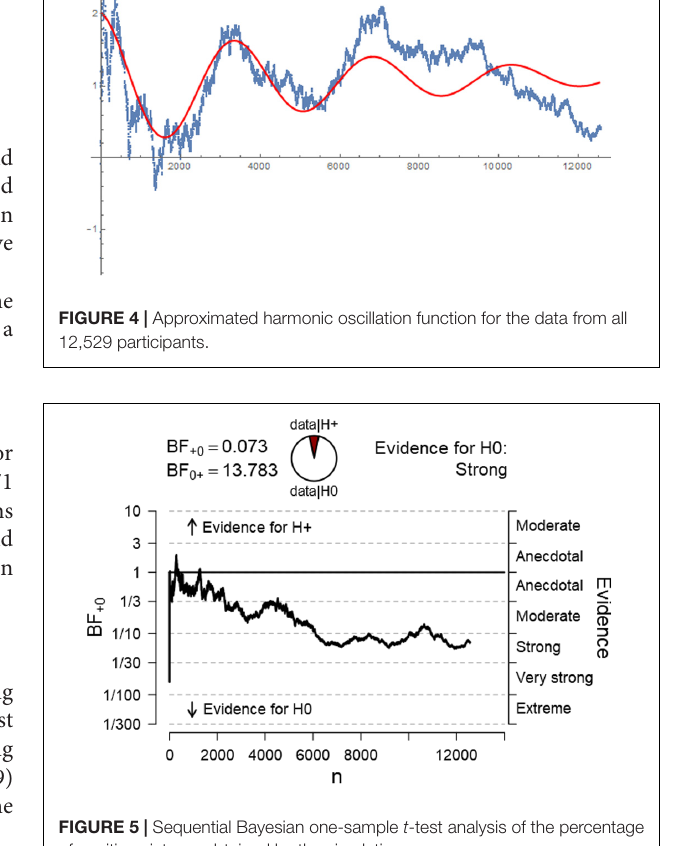
FIGURE 5 | Sequential Bayesian one-sample t -test analysis of the percentage of positive pictures obtained by the simulation.